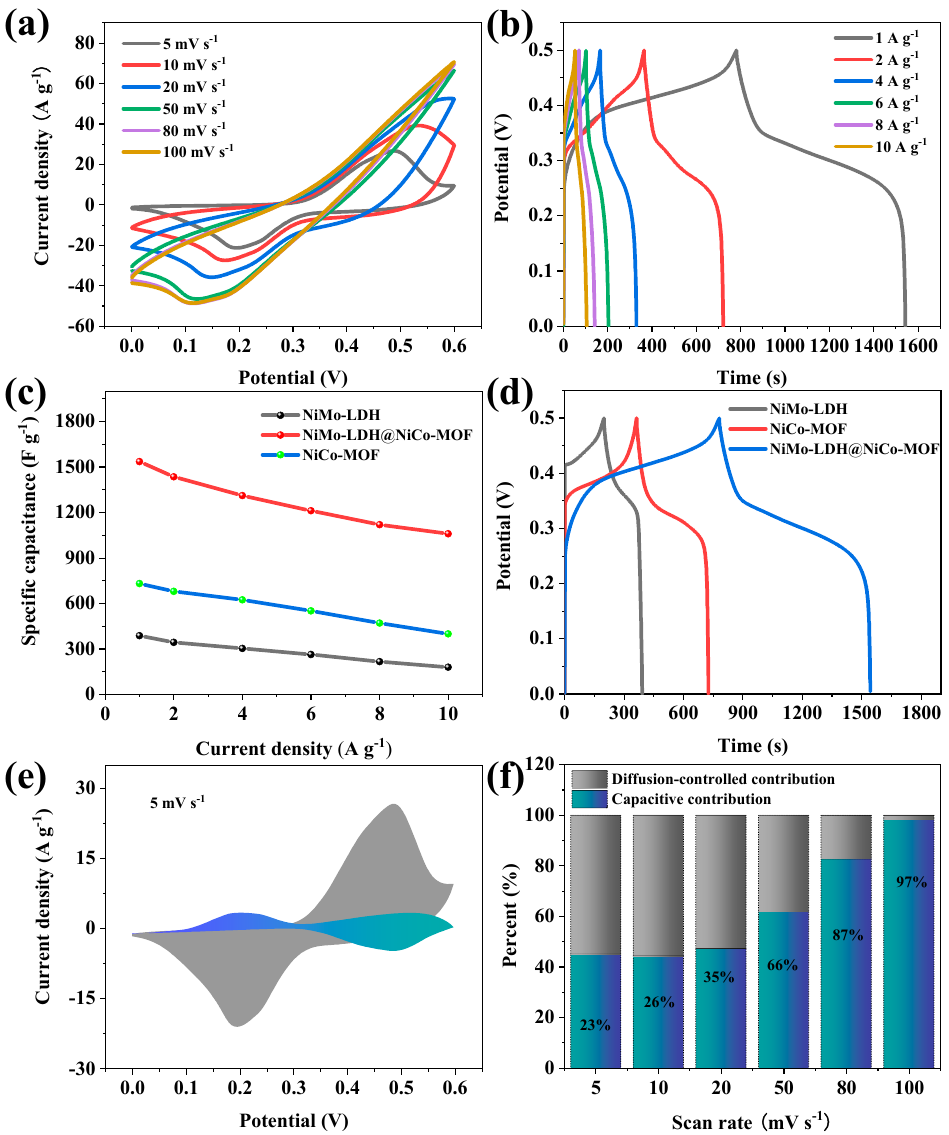
Figure 9. ( a ) CV curves of NiMo-LDH@NiCo-MOF; ( b ) GCD curves of NiMo-LDH@NiCo-MOF at 1-10 A g − 1 ; ( c ) specific capacitance of NiMo-LDH@NiCo-MOF, NiMo-LDH, and NiCo-MOF; ( d ) GCD curves; ( e ) capacitance and diffusion contribution at 5 mV s -1 ; ( f ) proportion of capacitance contribution.